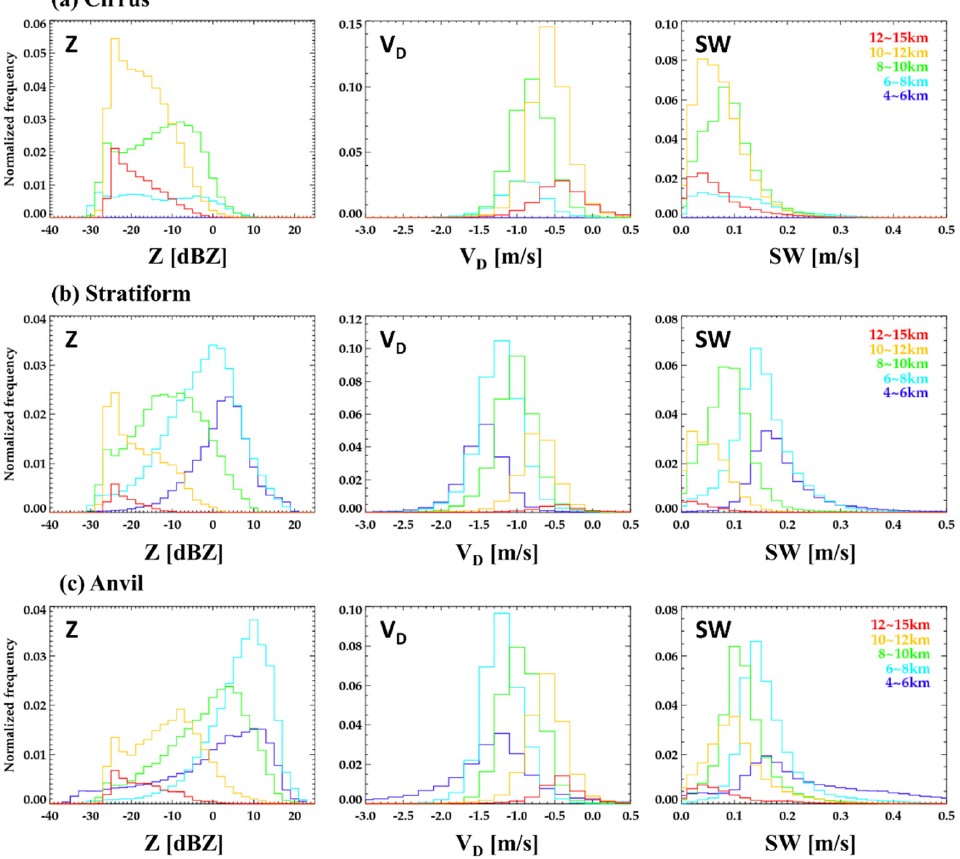
Figure 5. Histograms of Z , V D , and SW for ( a ) cirrus, ( b ) stratiform, and ( c ) anvil with various cloud heights (blue: 4–6 km, cyan: 6–8 km, green: 8–10 km, yellow: 10–12 km, and red: 12–15 km).